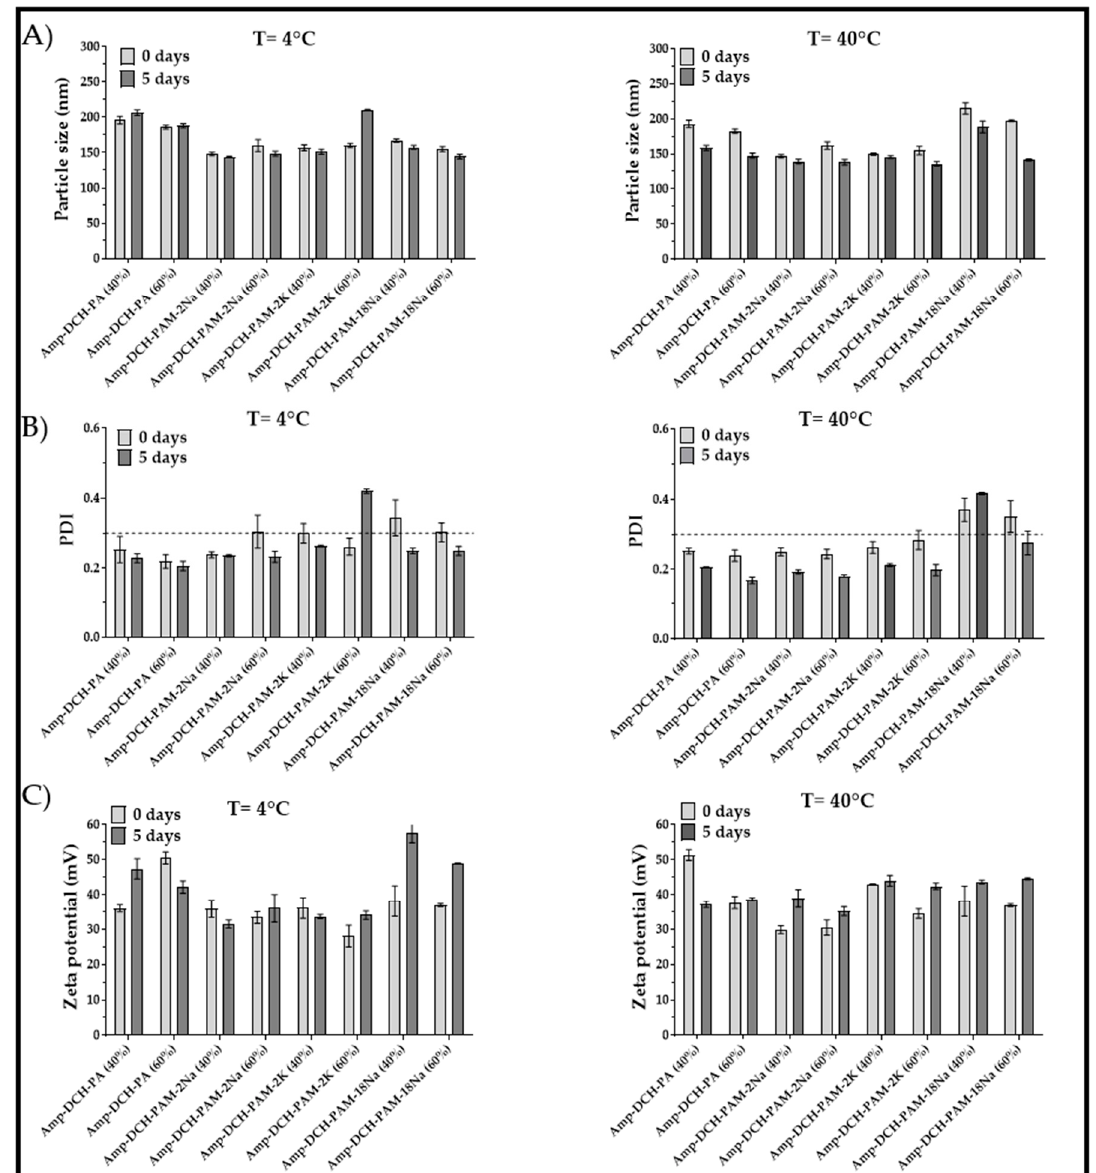
Figure 3. Stress studies conducted at 4 ◦ C and 40 ◦ C for ampicillin-loaded nanoparticulate systems: ( A ) particle size, ( B ) polydispersity and ( C ) zeta potential.